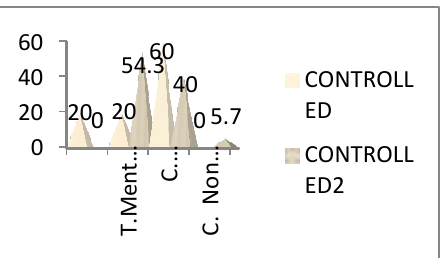
Figure 13: Relationship between diabetic profiles and the type of tinea pedis. Figure 14: Relationship between diabetic profiles and The Causative